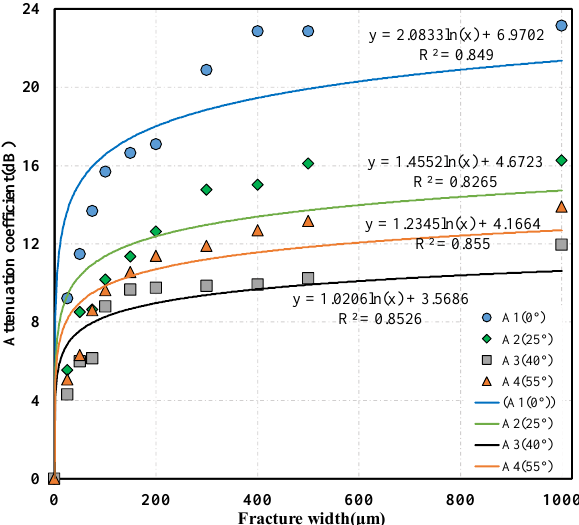
Figure 10. Relationship between shear wave attenuation coefficient and fracture width of the set of A cores containing fractures with different dip angles.